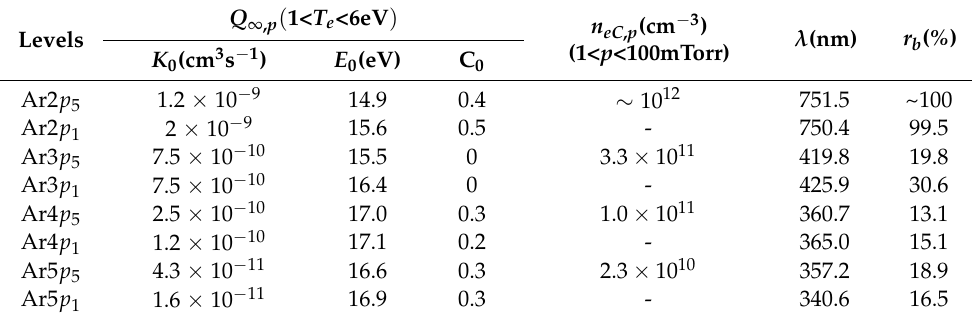
Table 2. Data for argon n p levels with J = 0